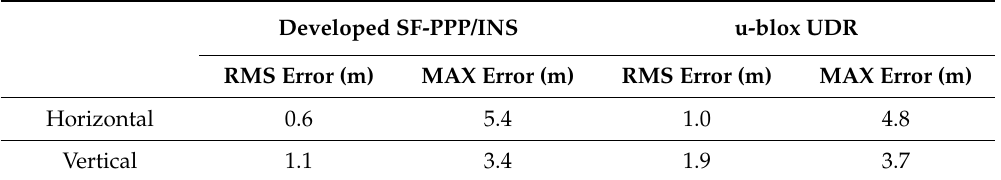
Table 1. The first trajectory RMS and maximum position errors after 5 min. The first five minutes were excluded to avoid the effect of the time needed to acquire the ionospheric corrections on the comparison.